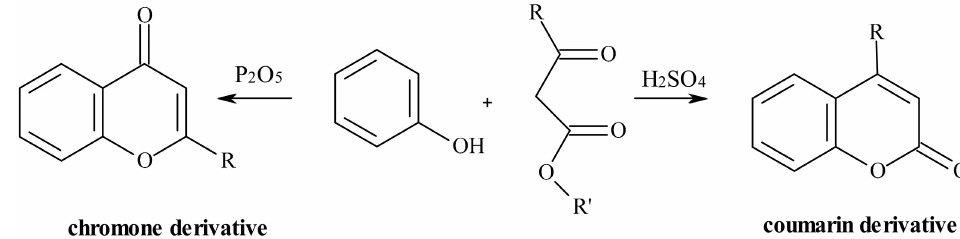
Scheme 2. Products of cyclization according to Simonis (2-substituted chromone derivatives)